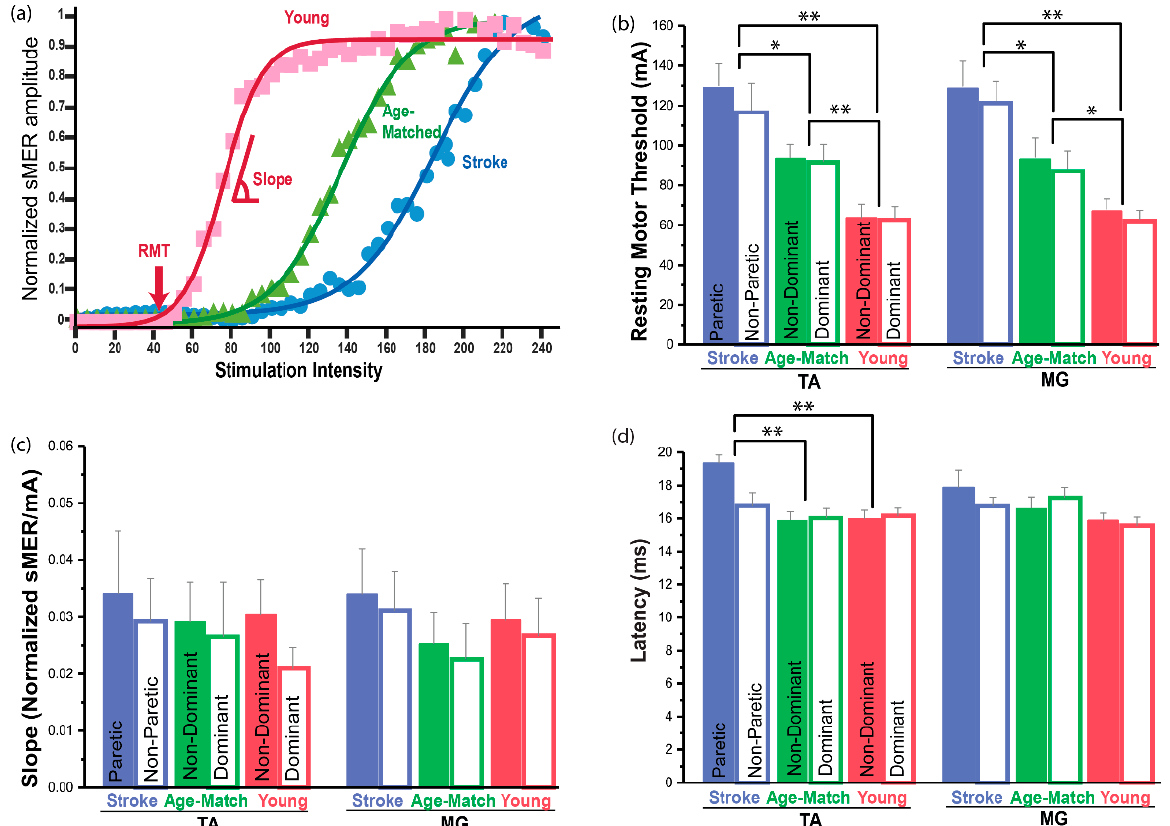
Figure 3. Comparison of electrophysiological parameters of sMERs by group and side. ( a ) sMER recruitment curves of a representative participant from each group. The recruitment curve of the age-matched control group shifted to the right (i.e., higher RMT) compared to the younger control group, while that of the stroke group further shifted to the right compared to the age-matched control group. These participants had similar slopes, but the RMT was the highest for the stroke group, followed by the age-matched control group, with the younger control group having the lowest RMT. Electrophysiological parameters presented for TA and MG muscles as a function of group and side. ( b ) Resting motor threshold (RMT), ( c ) slope of sMER recruitment curve, and ( d ) sMER latency. Data are presented as the mean ± standard error (SE) * p < 0.050; ** p < 0.010.